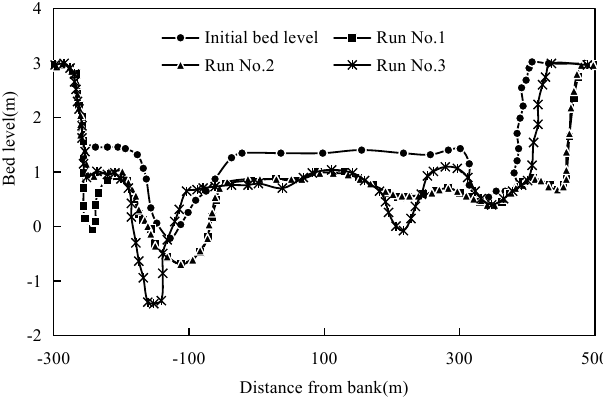
Figure 8. Comparison of bed deformation at the 6000 m cross-section.